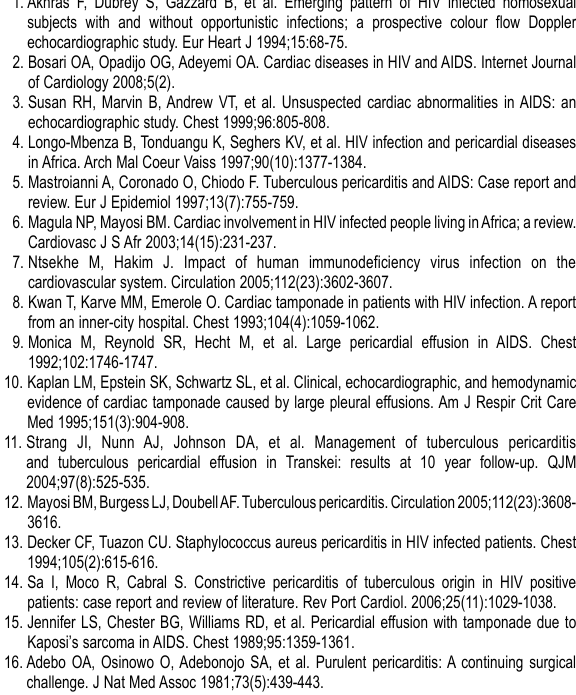
TABLE IV. TREATMENT OF PERICARDIAL DISEASE